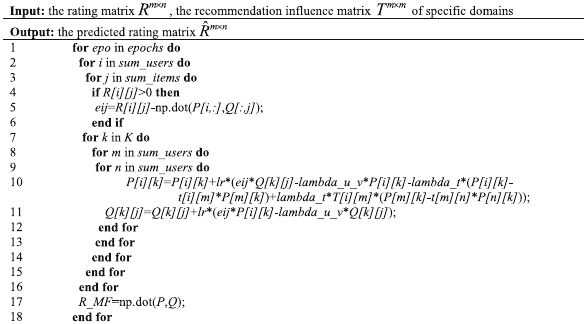
Algorithm 2. The user-item rating matrix for prediction